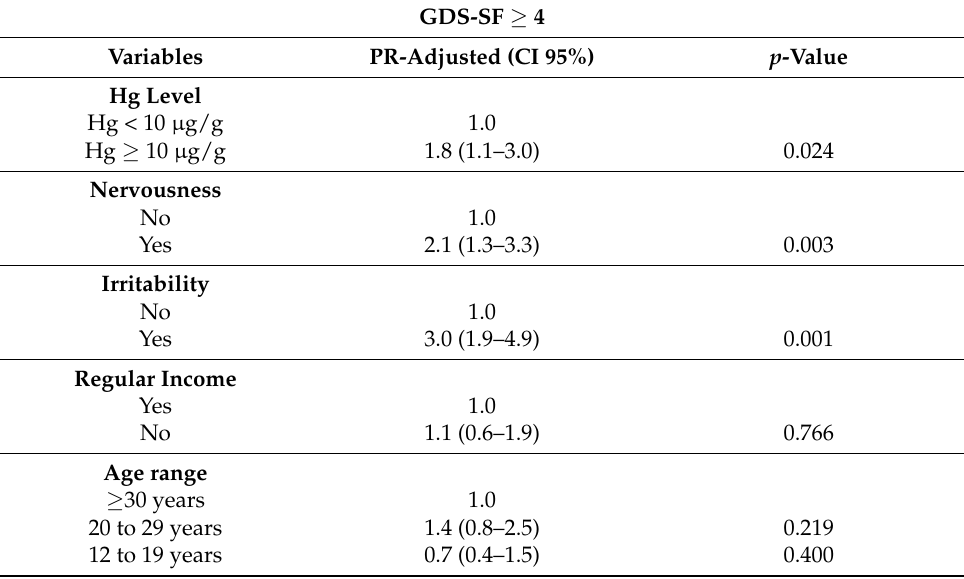
Table 3. Clinical and sociodemographic variables, according to GDS-SF scores ≥ 4 (adjusted Poisson regression model). Sawr é Muybu Indigenous Land, Par á , Amazon, Brazil, 2019. GDS-SF ≥